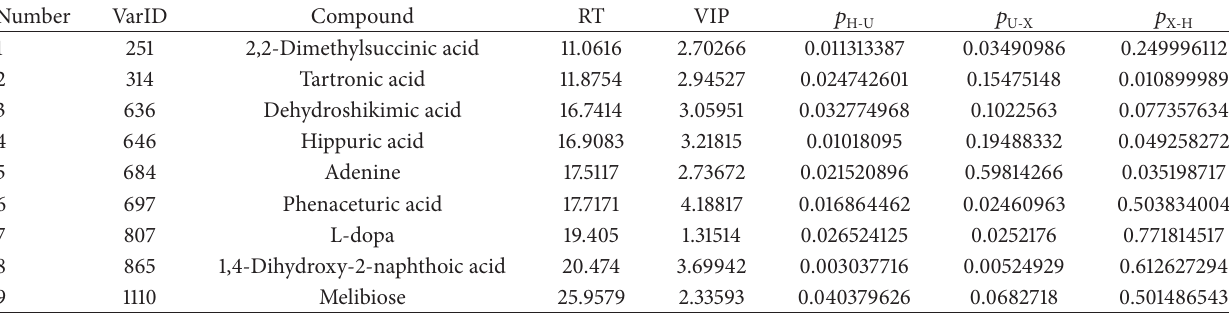
Table 2: Potential biomarkers selected and change of trend in each group.